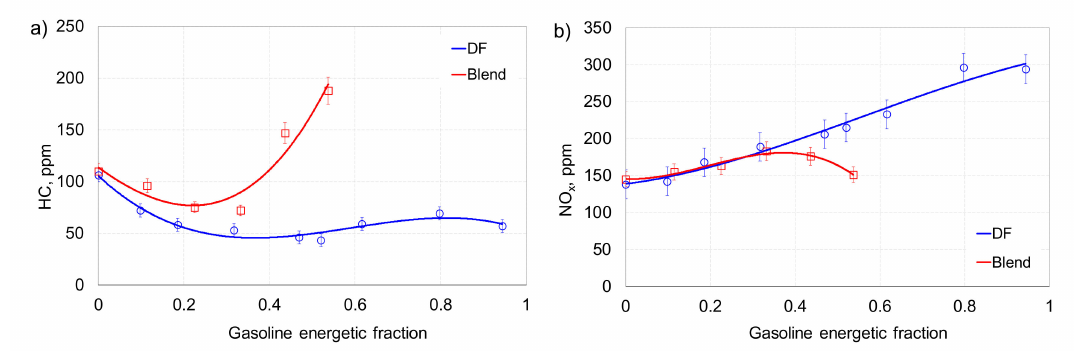
Figure 16. Emission of unburned hydrocarbons (HC) ( a ) and nitrogen oxides (NO x ) ( b